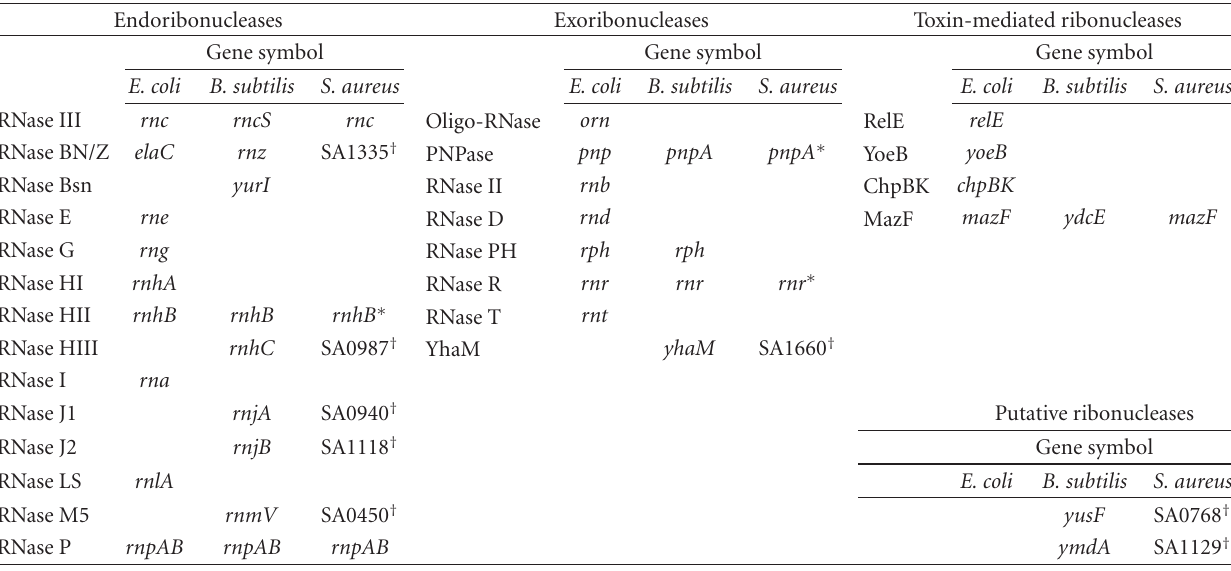
Table 1: E. coli, B. subtilis, and S. aureus ribonucleases.